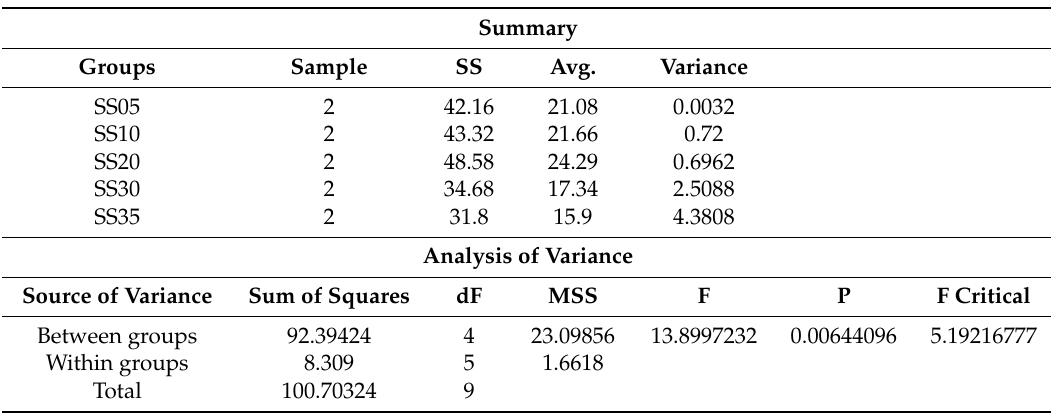
Table 4. Single factor ANOVA analysis for net biomass generation